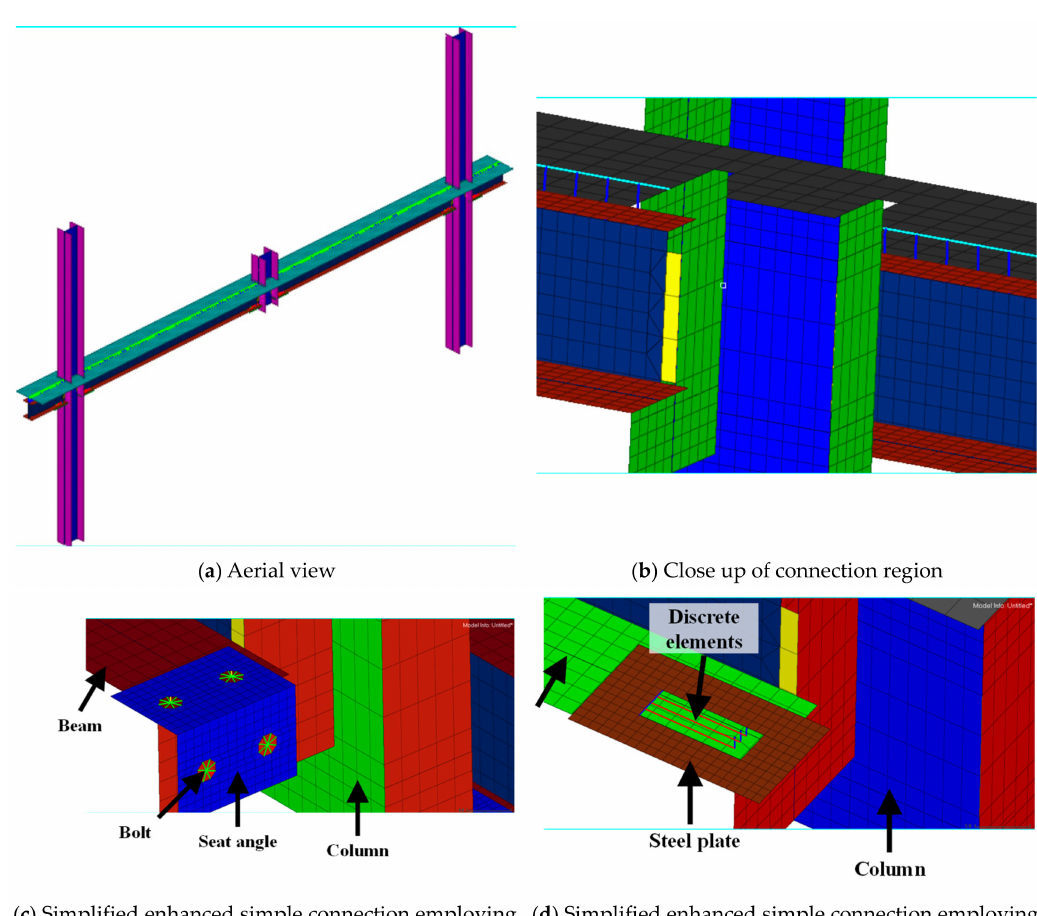
Figure 25. Simplified unenhanced and enhanced planar composite frame